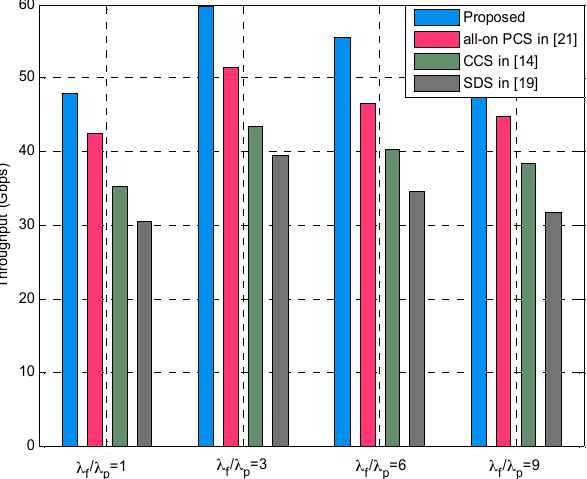
Figure 11. Overall throughput of small cells under different SBS density ratios when T p = 5.5 dB, T f = 1.0 dB.